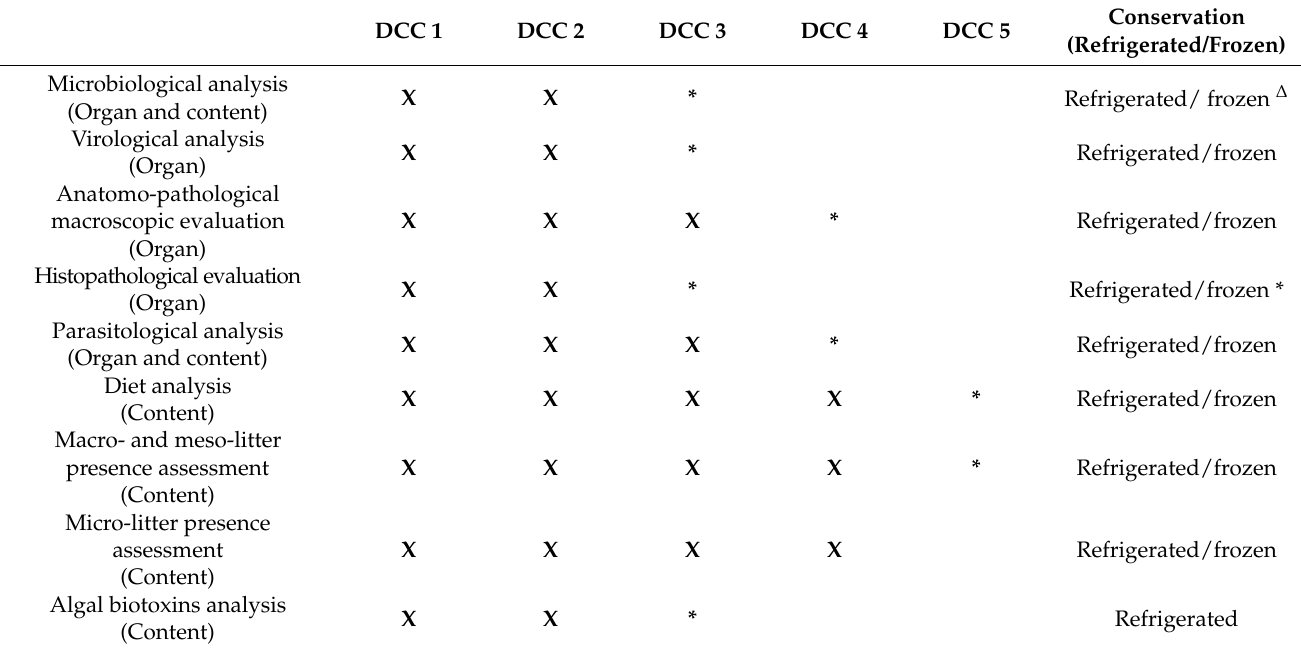
Table 4. Analysis that can be performed on GIT organs according to the decomposition condition code (DCC) and conservation of both the organs and content. X = suitable, * = limited, ∆ = limited to Polymerase Chain Reaction (PCR) analysis, microbiological cultures cannot be performed